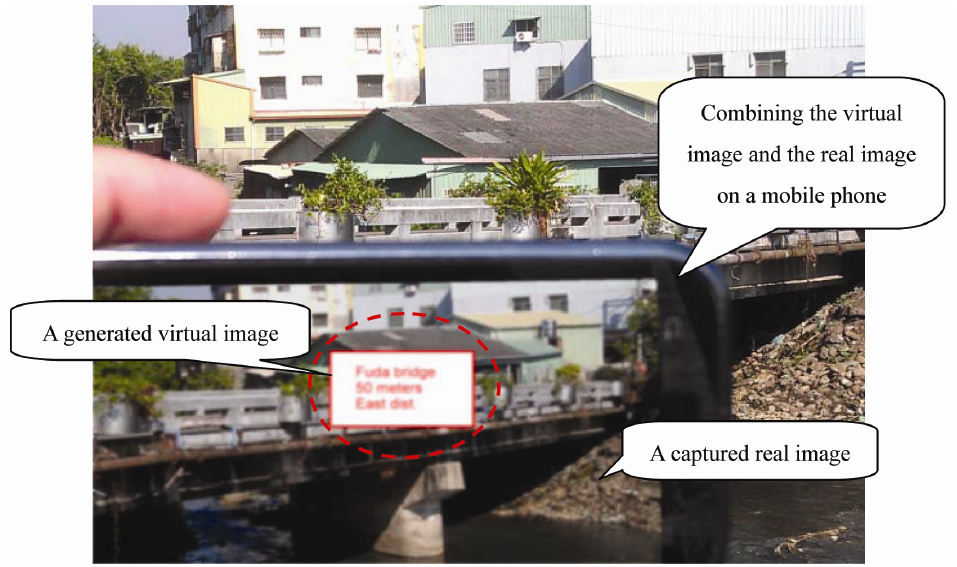
Fig. 2. Recognizing a bridge through AR-based